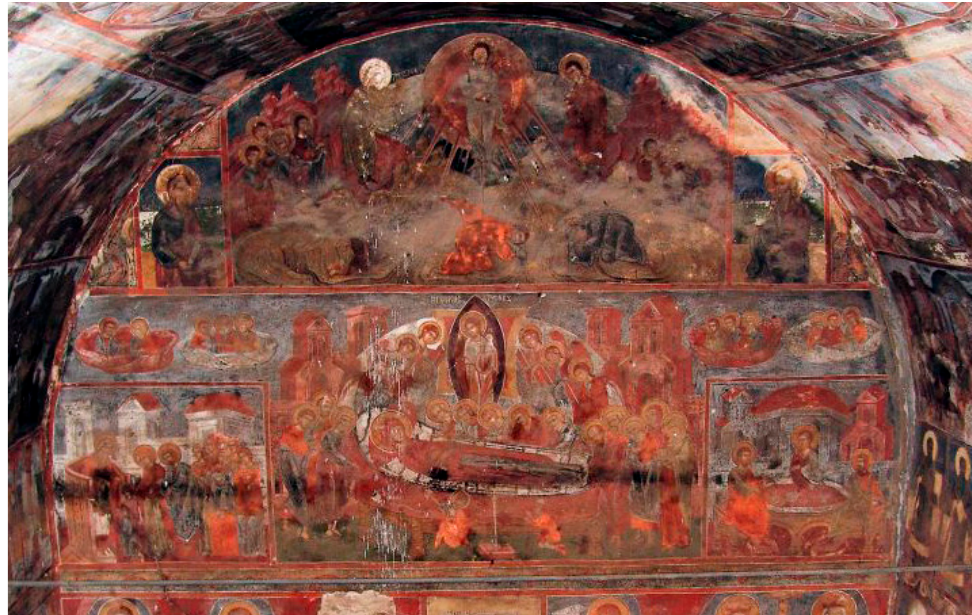
Figure 16. Dormition of the Theotokos , wall painting, 1616, Church of St. Nicholas, Seslavtsi Monastery, Bulgaria. (Photo credit: Ivan Vanev, The Roads of the Balkan Painters and Post-Byzantine Artistic Heritage in Bulgaria Project, http://zografi.info/, accessed on 2 February 2023). Mandorlas composed of two elements, the central of which is red, are often present